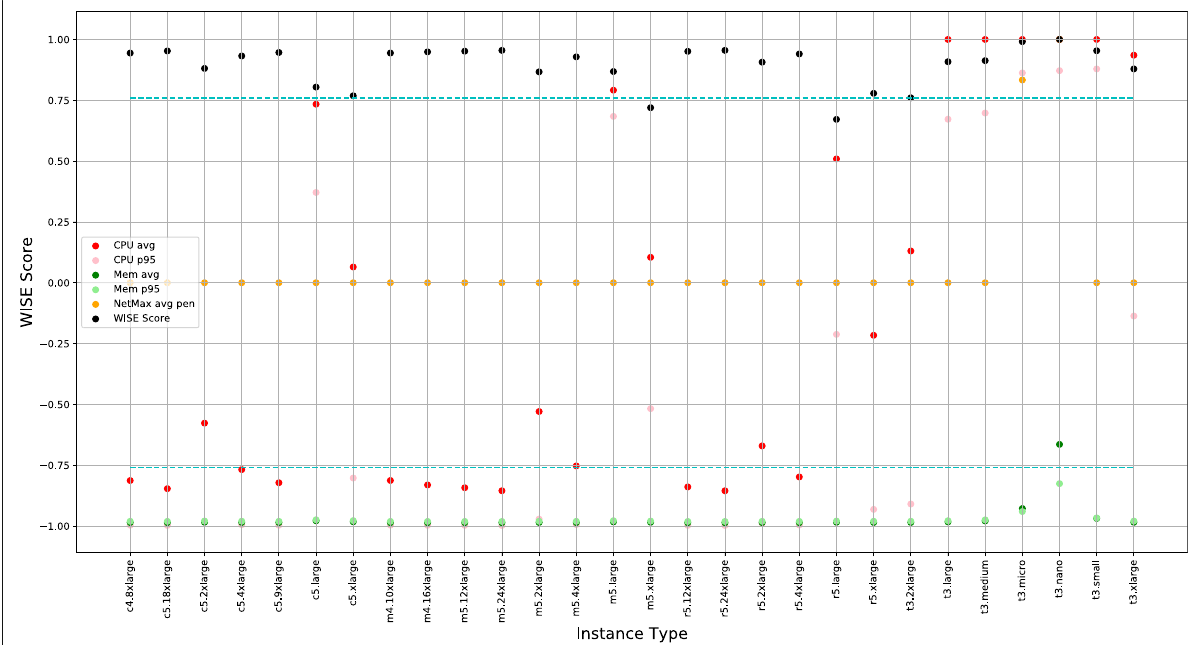
light blue dotted lines indicates values that fall within the described acceptable ranges. Any value that falls outside of this region indicates over- or under-utilization from the acceptable ranges. A machine score can still fall within the acceptable range while having a resource that falls out of